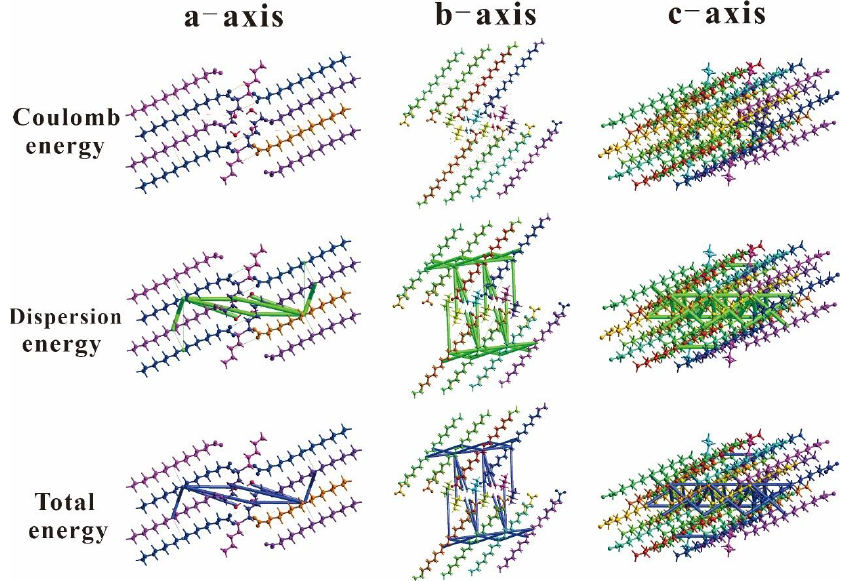
Figure 9. The diagrams of the interaction energies: Coulomb energy, dispersion energy, and total energy of 3C17 molecule along the a, b, and c axes. k ele = 1.019, k pol = 0.651, k dis = 0.901, and k rep = 0.811 [52]. Calculations on the data from